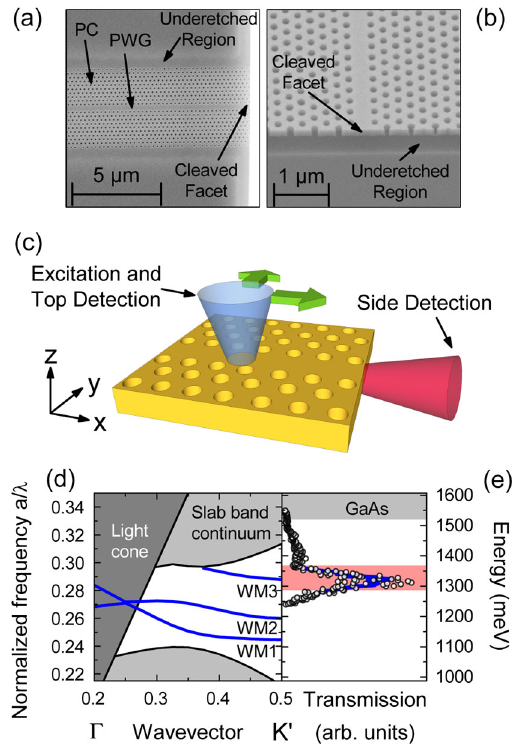
FIG. 1. (a) and (b) SEM images of the W1 waveguide from the top and from the side, respectively. (c) Schematic of the excita- tion and detection geometry. (d) Photonic band-structure calcu- lations for a W1 waveguide with r=a ¼ 0 : 26 and h=a ¼ 0 : 6667 . The solid blue lines correspond to the photonic waveguide modes and the light gray region to the slab waveguide modes. The dark gray region indicates the light cone. (e) Spectral transmission of the waveguide for illumination from the top at the inner end of the waveguide and detection from the side at the cleaved end. The red (light gray) shaded region marks the spectral region of quantum dot emission (bulk